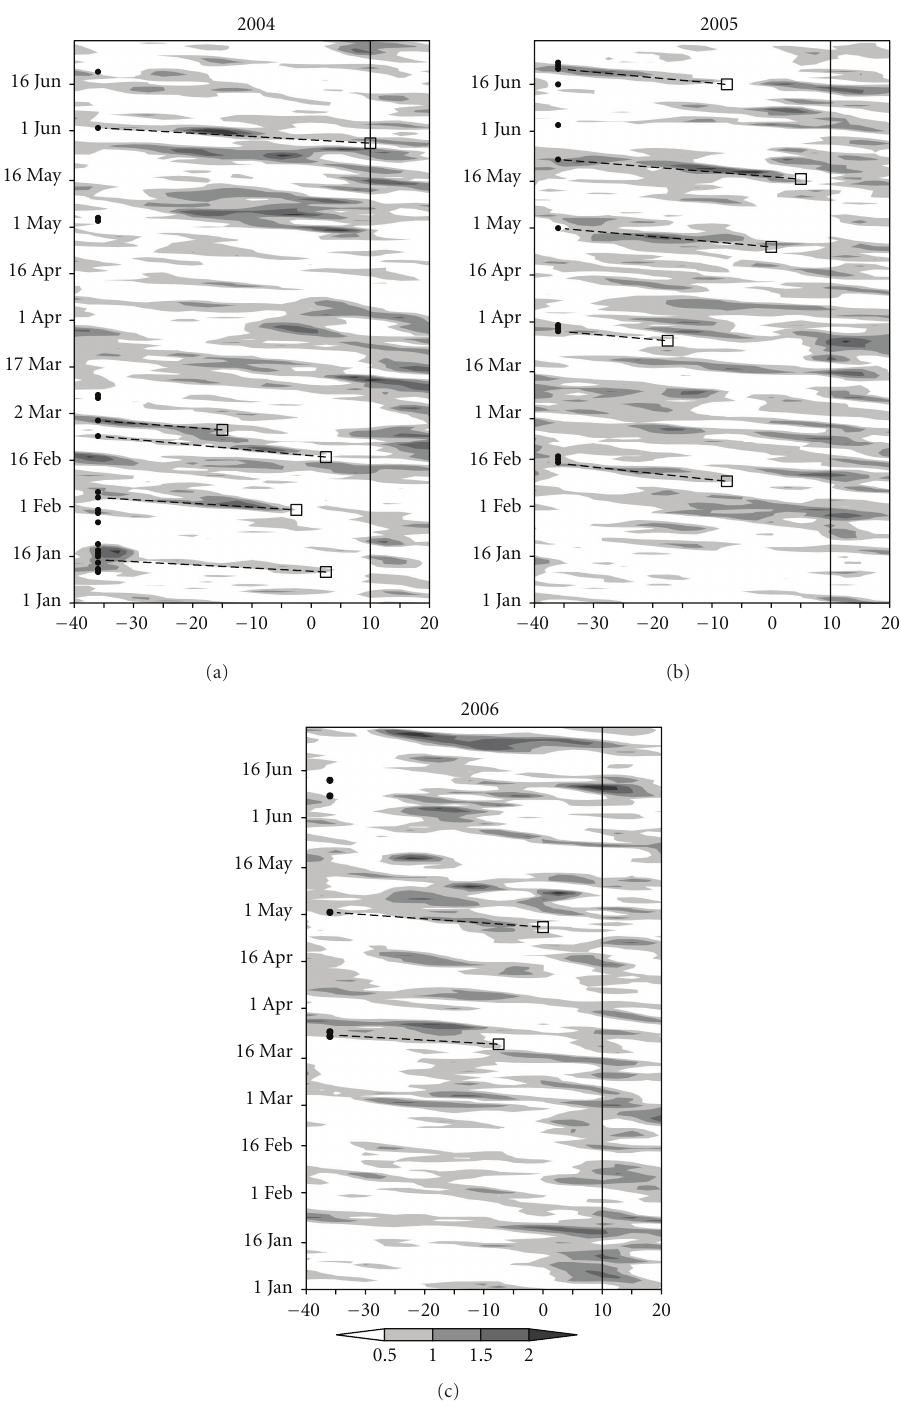
Figure 4: 700 hPa daily positive vorticity (10 − 5 · s − 1 ) from January–June in (a) 2004, (b) 2005, and (c) 2006 along 40 ◦ W–20 ◦ E averaged between 2.5 ◦ S and 12.5 ◦ S. The vertical solid line at 10 ◦ E represents the approximate eastern limit of the African continent. Positive strong daily rainfall anomalies ( > 10mm · day − 1 ) over ENEB are schematized by black dots at 36 ◦ W. Selected EW onsets, marked by squares, are connected by a dashed line to the strong rainy